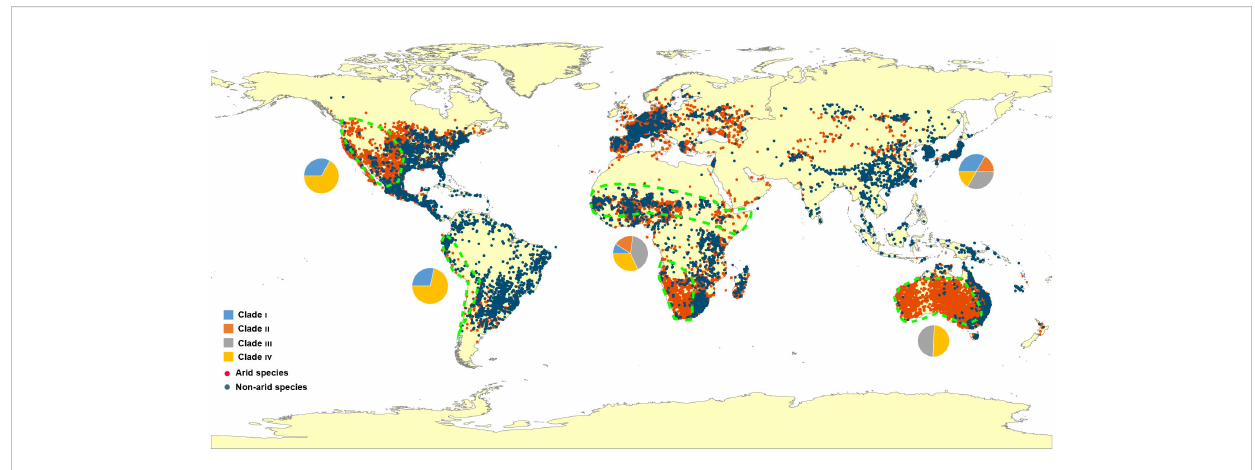
FIGURE 4 Map of locations and distributions of Eragrostis species used in this study. The regions surrounded by the green dashed lines represent the overlapping arid areas according to the arid species and the survey of International Arid Lands Consortium (http://pubs.usgs.gov/gip/deserts/what/ world.html). Red dots, arid species; Dark blue dots, Non-arid species. The pie charts indicate the proportion of four major Clade I-IV in each continent. Blue, Clade I; Orange, Clade II; Grey, Clade III; Yellow, Clade